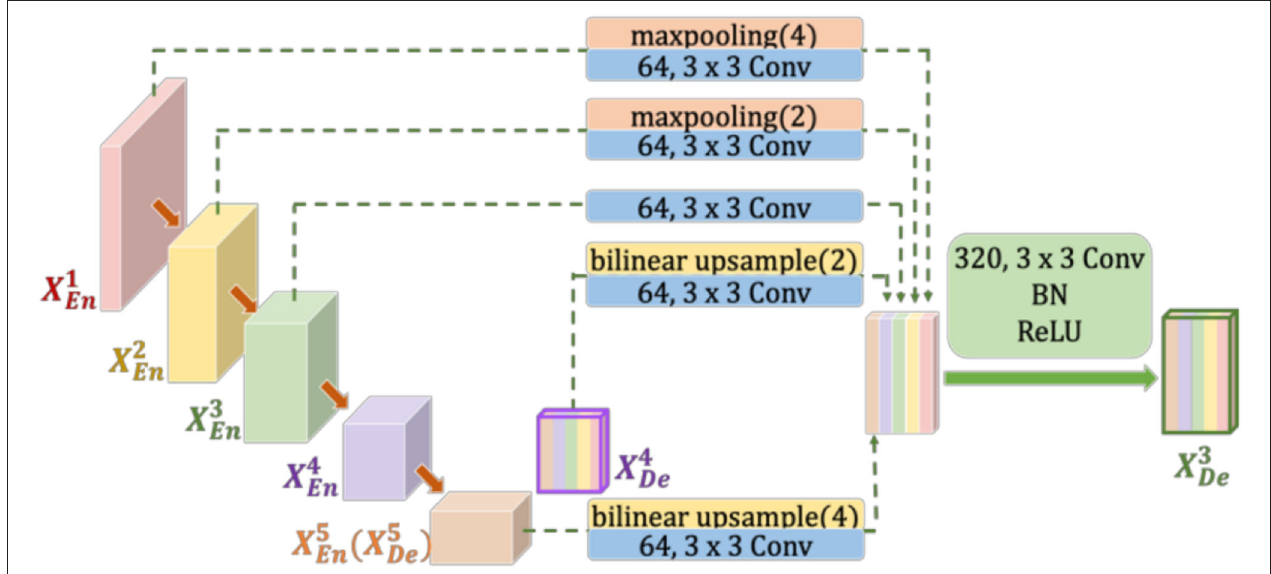
FIGURE 2 | Illustration of how to construct the full-scale aggregated feature map in the third decoder layer of UNet3 + . X 1 En ( X 1 De ) to X 5 En ( X 5 De ) represent the feature maps of the first to fifth layer encoders (decoders), respectively.